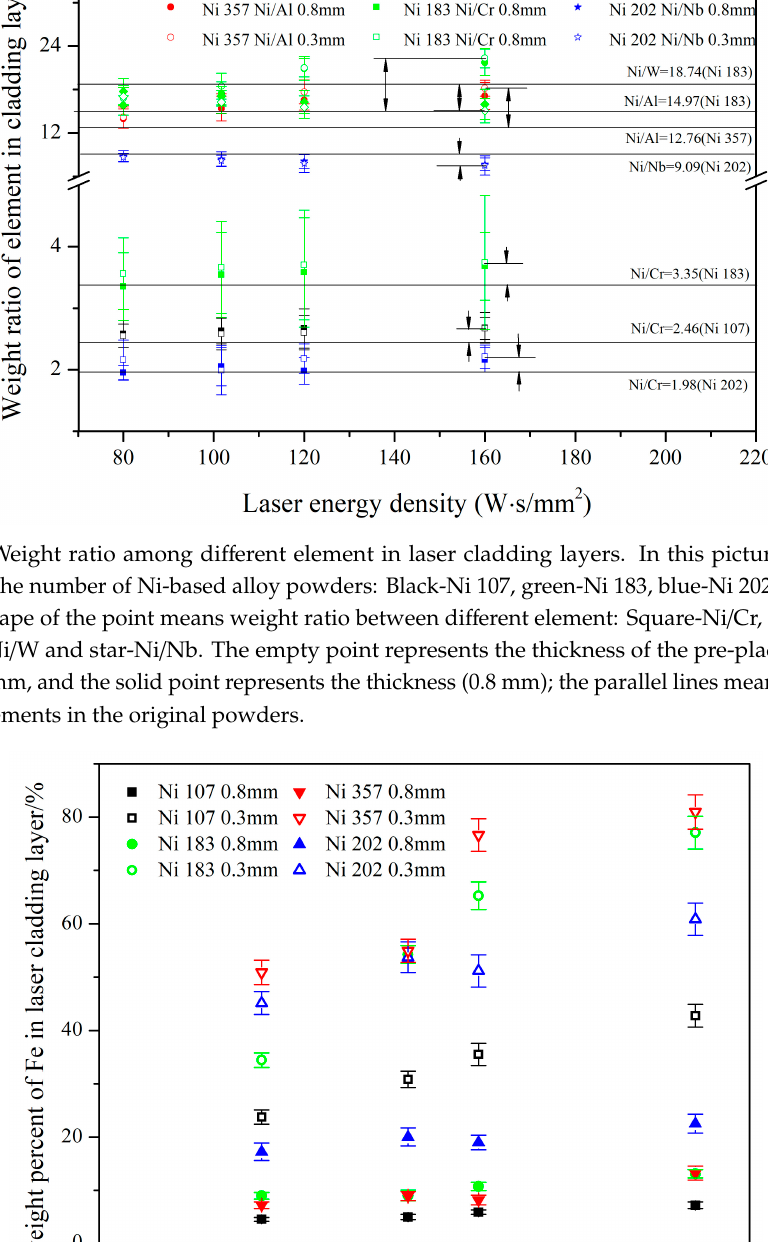
Figure 5. Weight ratio among different element in laser cladding layers. In this picture, the color represents the number of Ni ‐ based alloy powders: Black ‐ Ni 107, green ‐ Ni 183, blue ‐ Ni 202 and red ‐ Ni 357. The shape of the point means weight ratio between different element: Square ‐ Ni/Cr, circle ‐ Ni/Al, rhombus ‐ Ni/W and star ‐ Ni/Nb. The empty point represents the thickness of the pre ‐ placed powder layer (0.3) mm, and the solid point represents the thickness (0.8 mm); the parallel lines mean